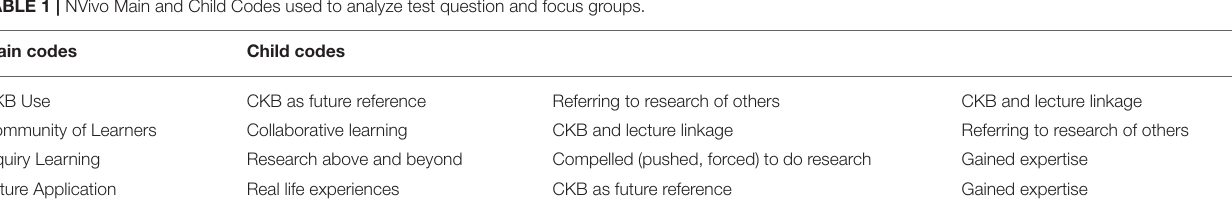
TABLE 1 | NVivo Main and Child Codes used to analyze test question and focus